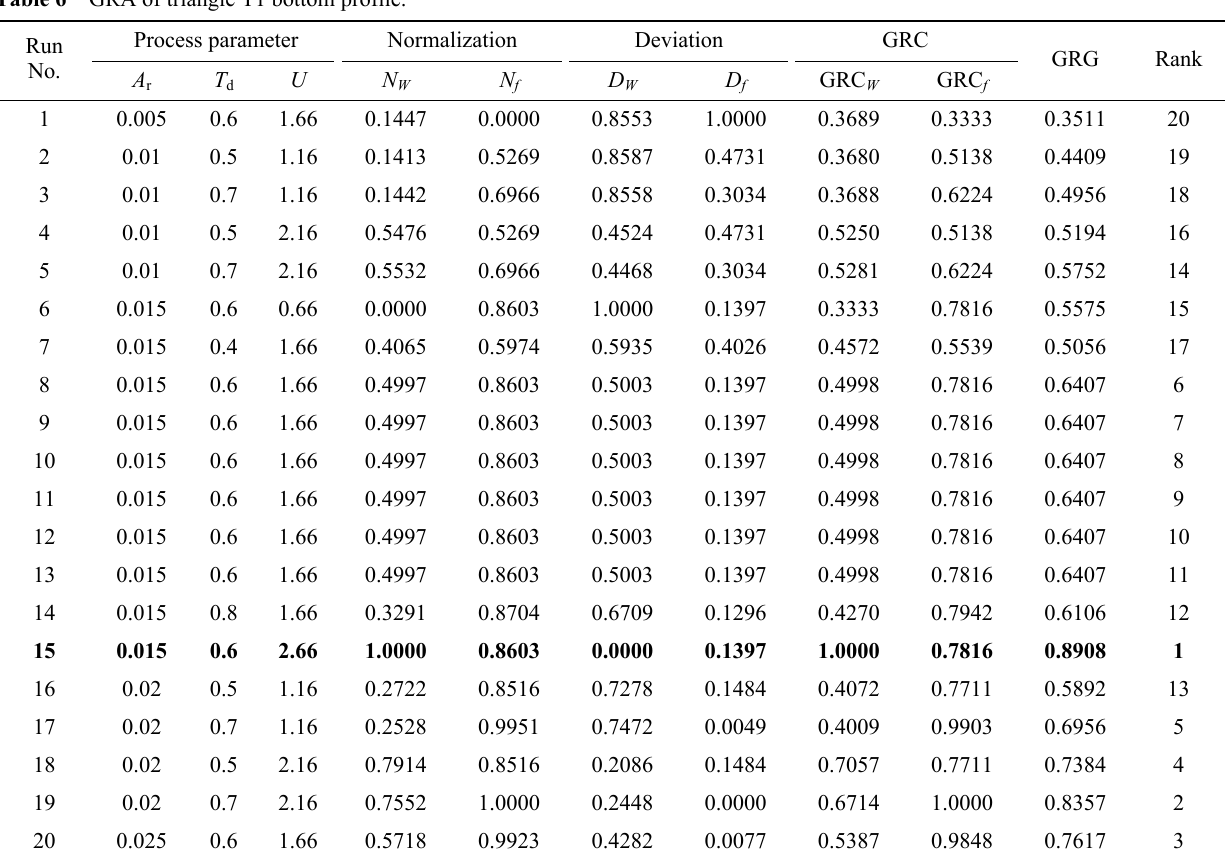
Table 6 GRA of triangle T1 bottom